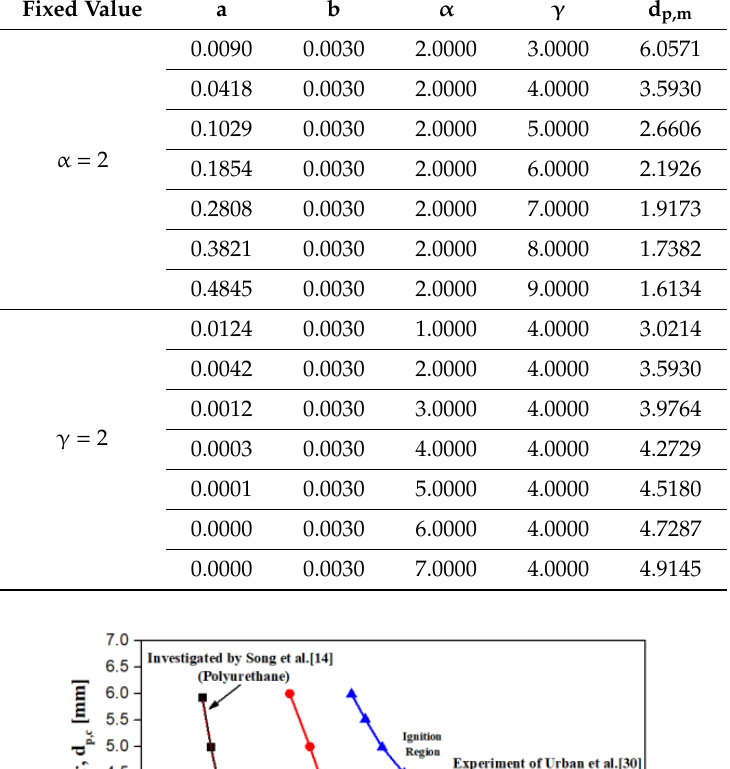
Table 1. Results of the coe ffi cients of the distribution function.